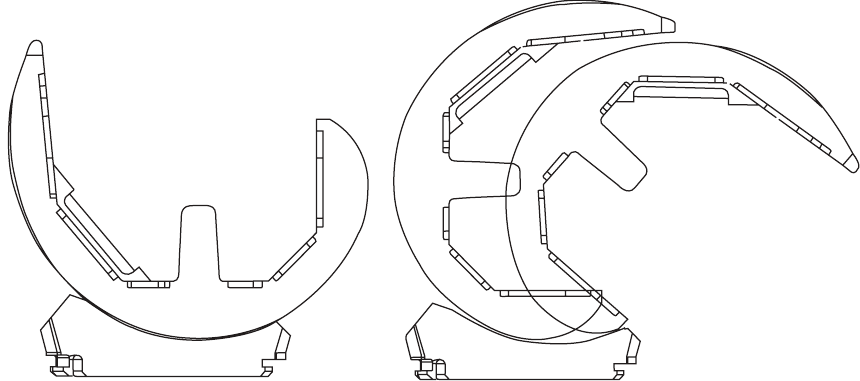
Figure 2: The 3D Knee fixed-bearing TKA design incorporates a hemispherical lateral condyle and tibial articulation to provide definitive AP translational control while providing for proper axial rotation. The asymmetric femoral component incorporates a constant sagittal radius from − 15 ∘ to 80 ∘ while providing progressively decreasing articular constraint with higher flexion to allow femoral condyle rollback. The posterior condyles are shaped to provide maximum posterior condylar offset late in the flexion arc. Table 1: Patient demographics and outcome measures for all TKA and for the PCL-retained and PCL-resected groups. All TKA PCL-retained PCL-resected 𝑃 ∗ Patients 159 116 43 Sex (F/M, % female) 98/61 (62%) 65/51 (56%) 33/10 (77%) 70 ±